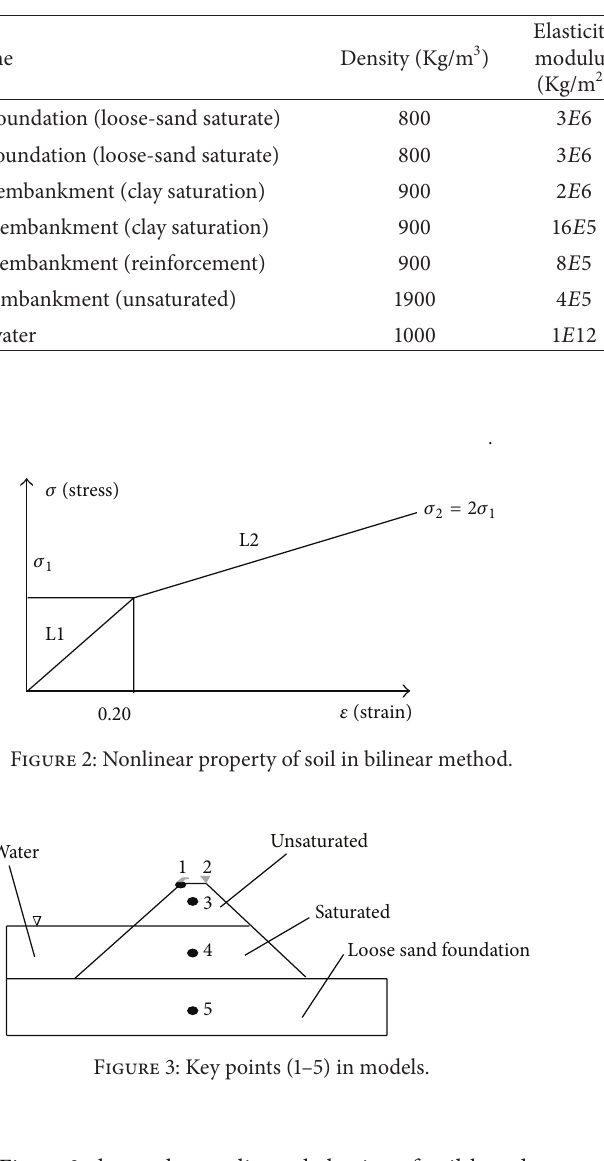
Table 2: Material properties.